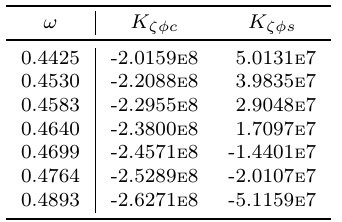
Table 14: Restoring force roll (wave)